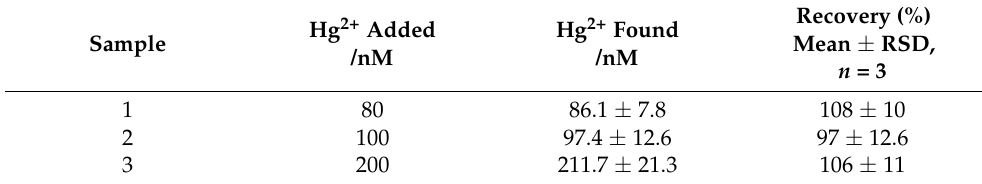
Table 2. Spiked recovery of the present fiber-optic SPR sensor for Hg 2+ ion detection in the tap water ( n =